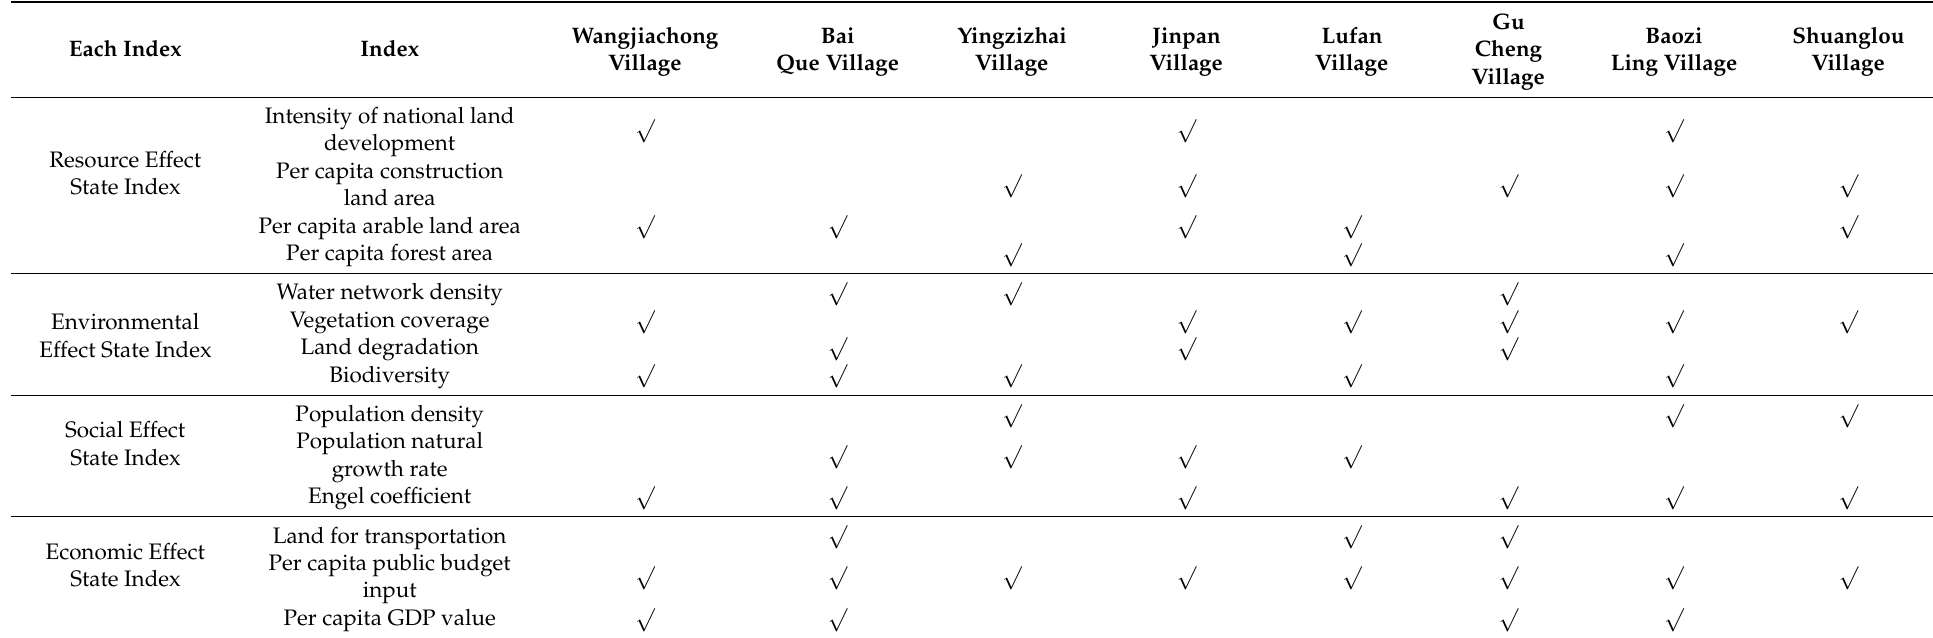
Table 2. The impact of eight villages on the ecological environment state